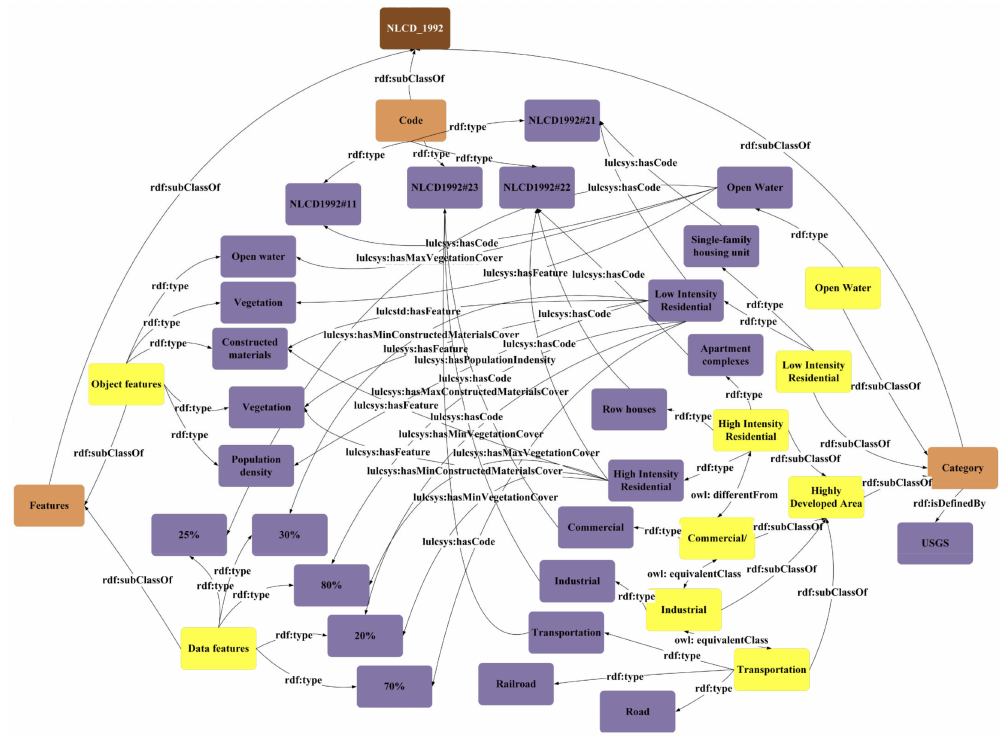
Figure 3. Partial structure of